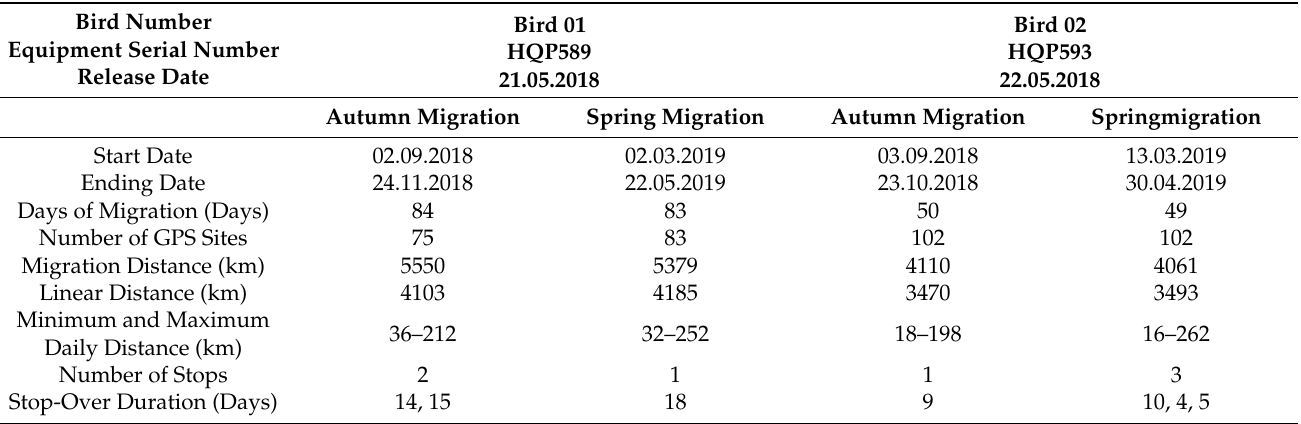
Table 1. Migration information of Chinese Sparrowhawks 01 and